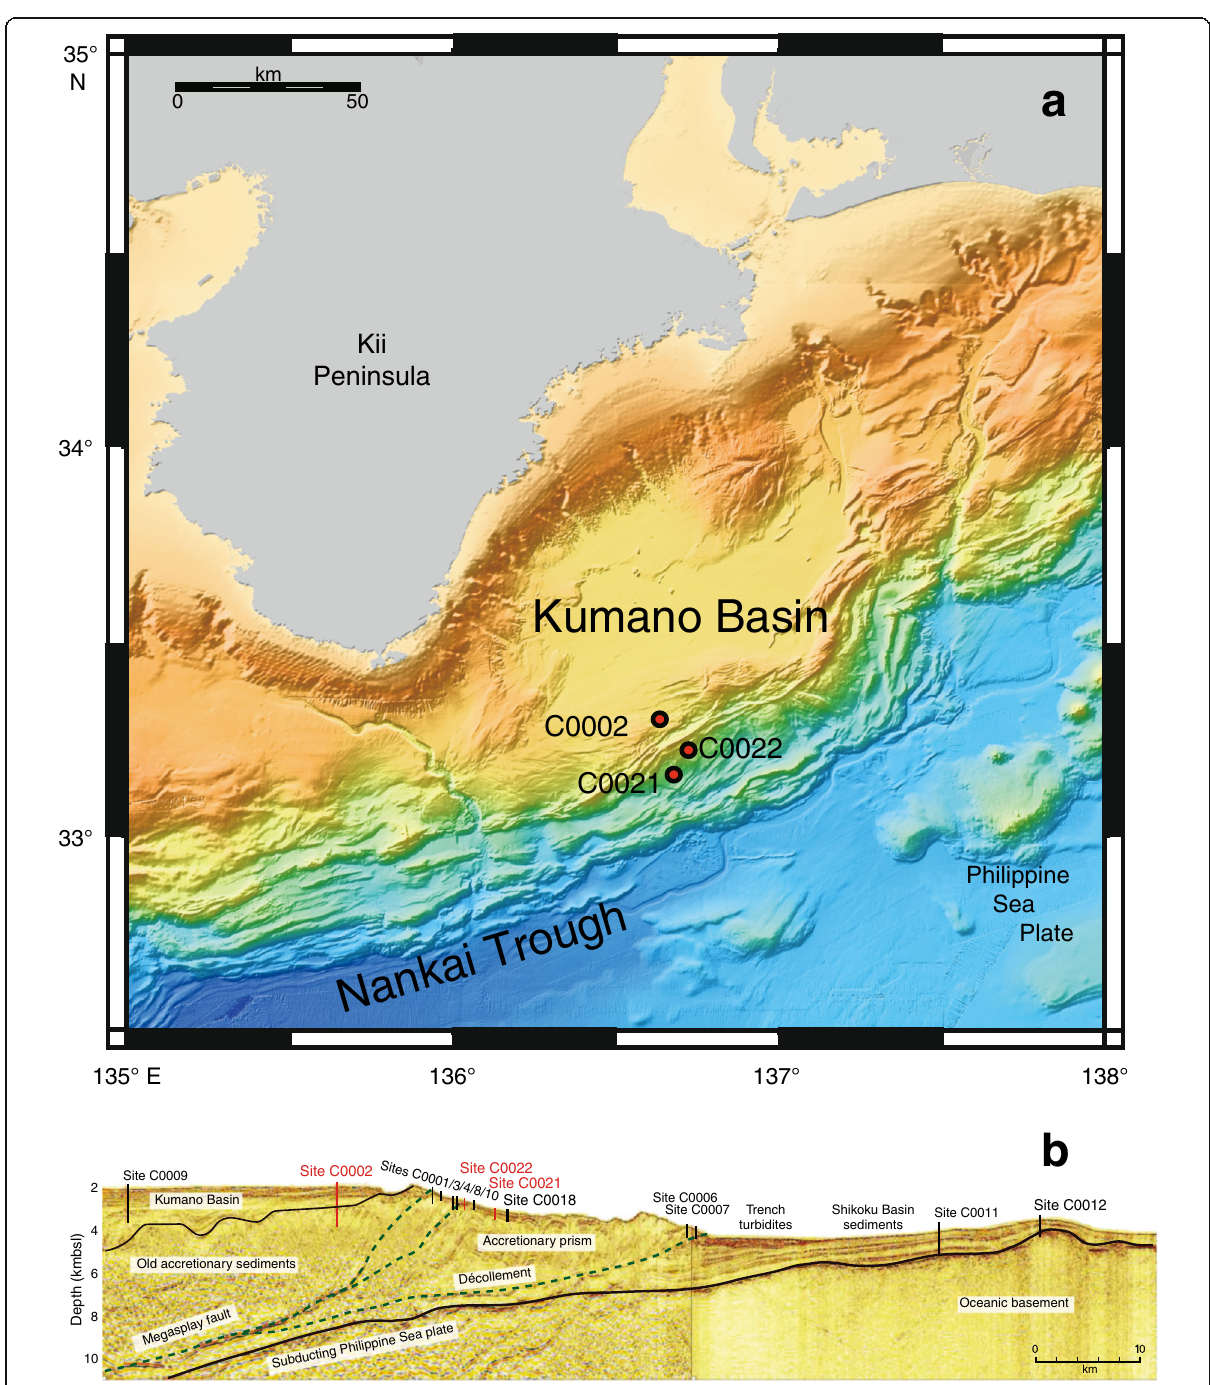
Fig. 1 Location of study sites (Sites C0002, C0021, and C0022, Kumano Basin, Nankai Trough) ( a ) and geological profile of the area ( b ) (Strasser et al.